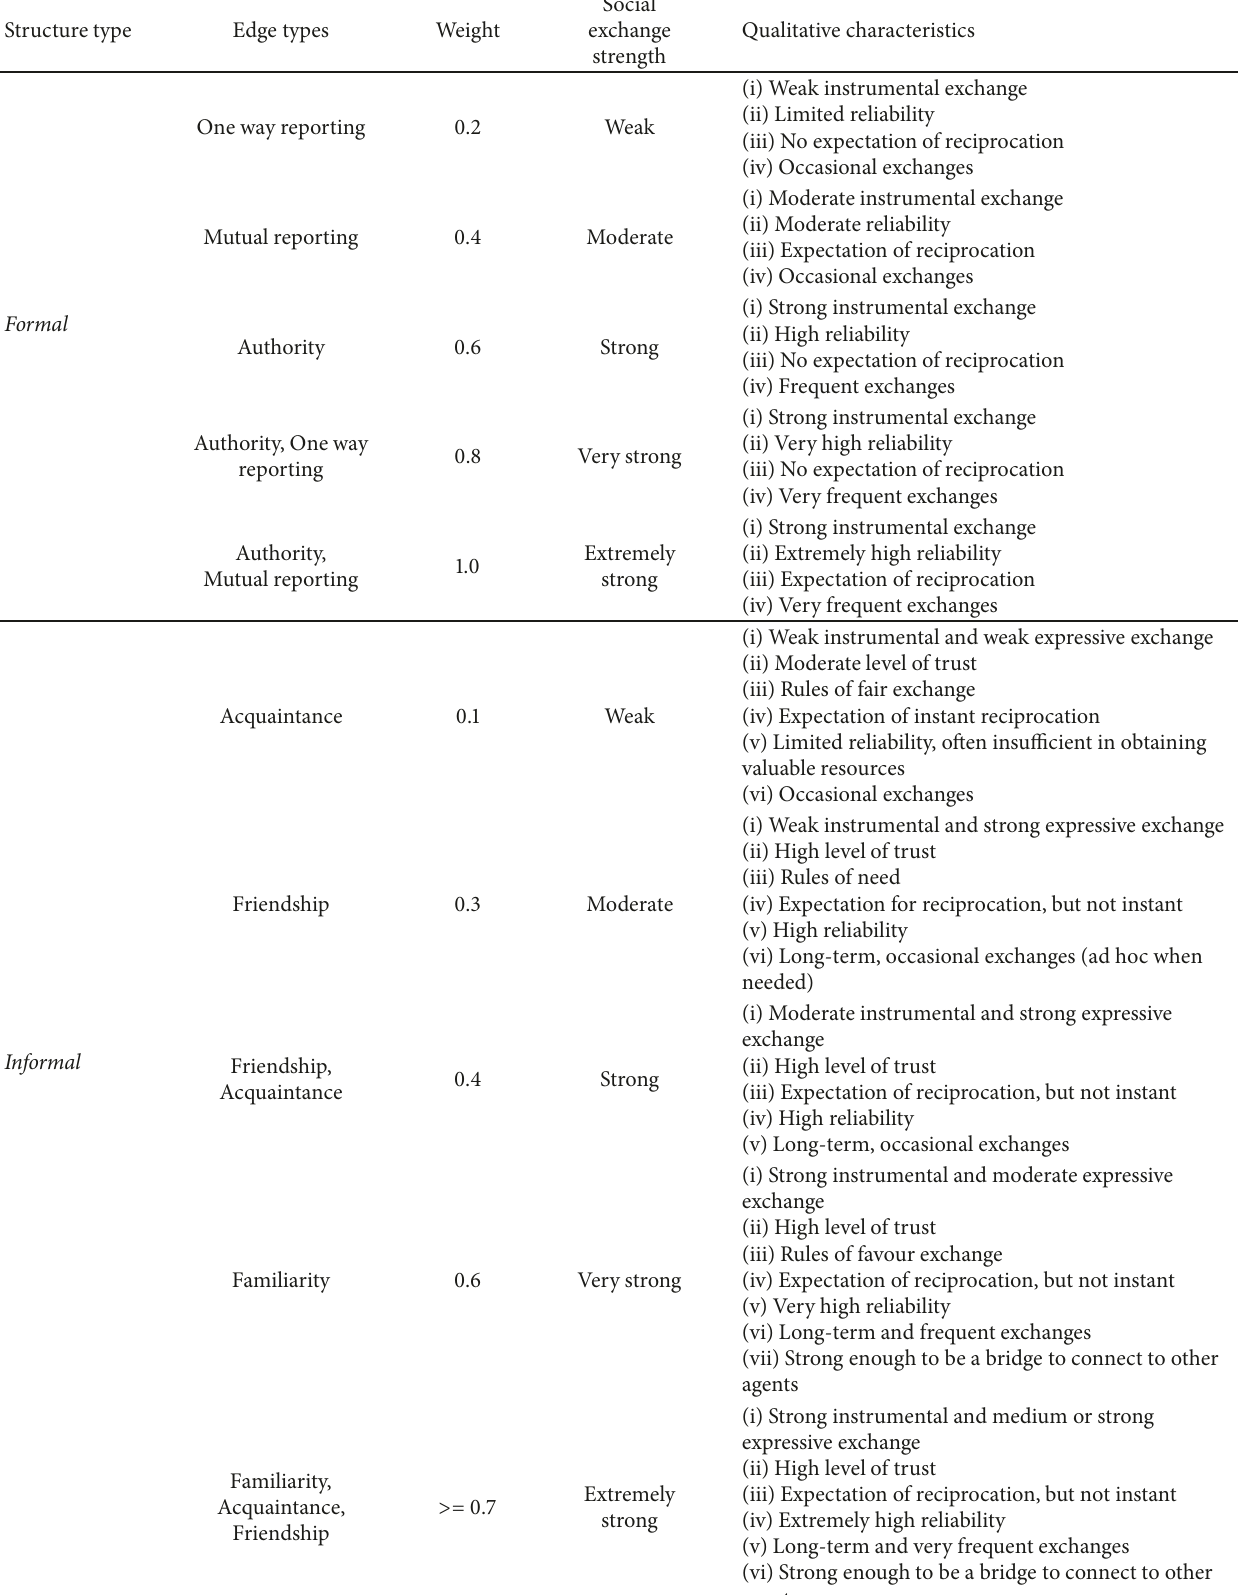
Table 2: Quantitative and qualitative characteristics of existing